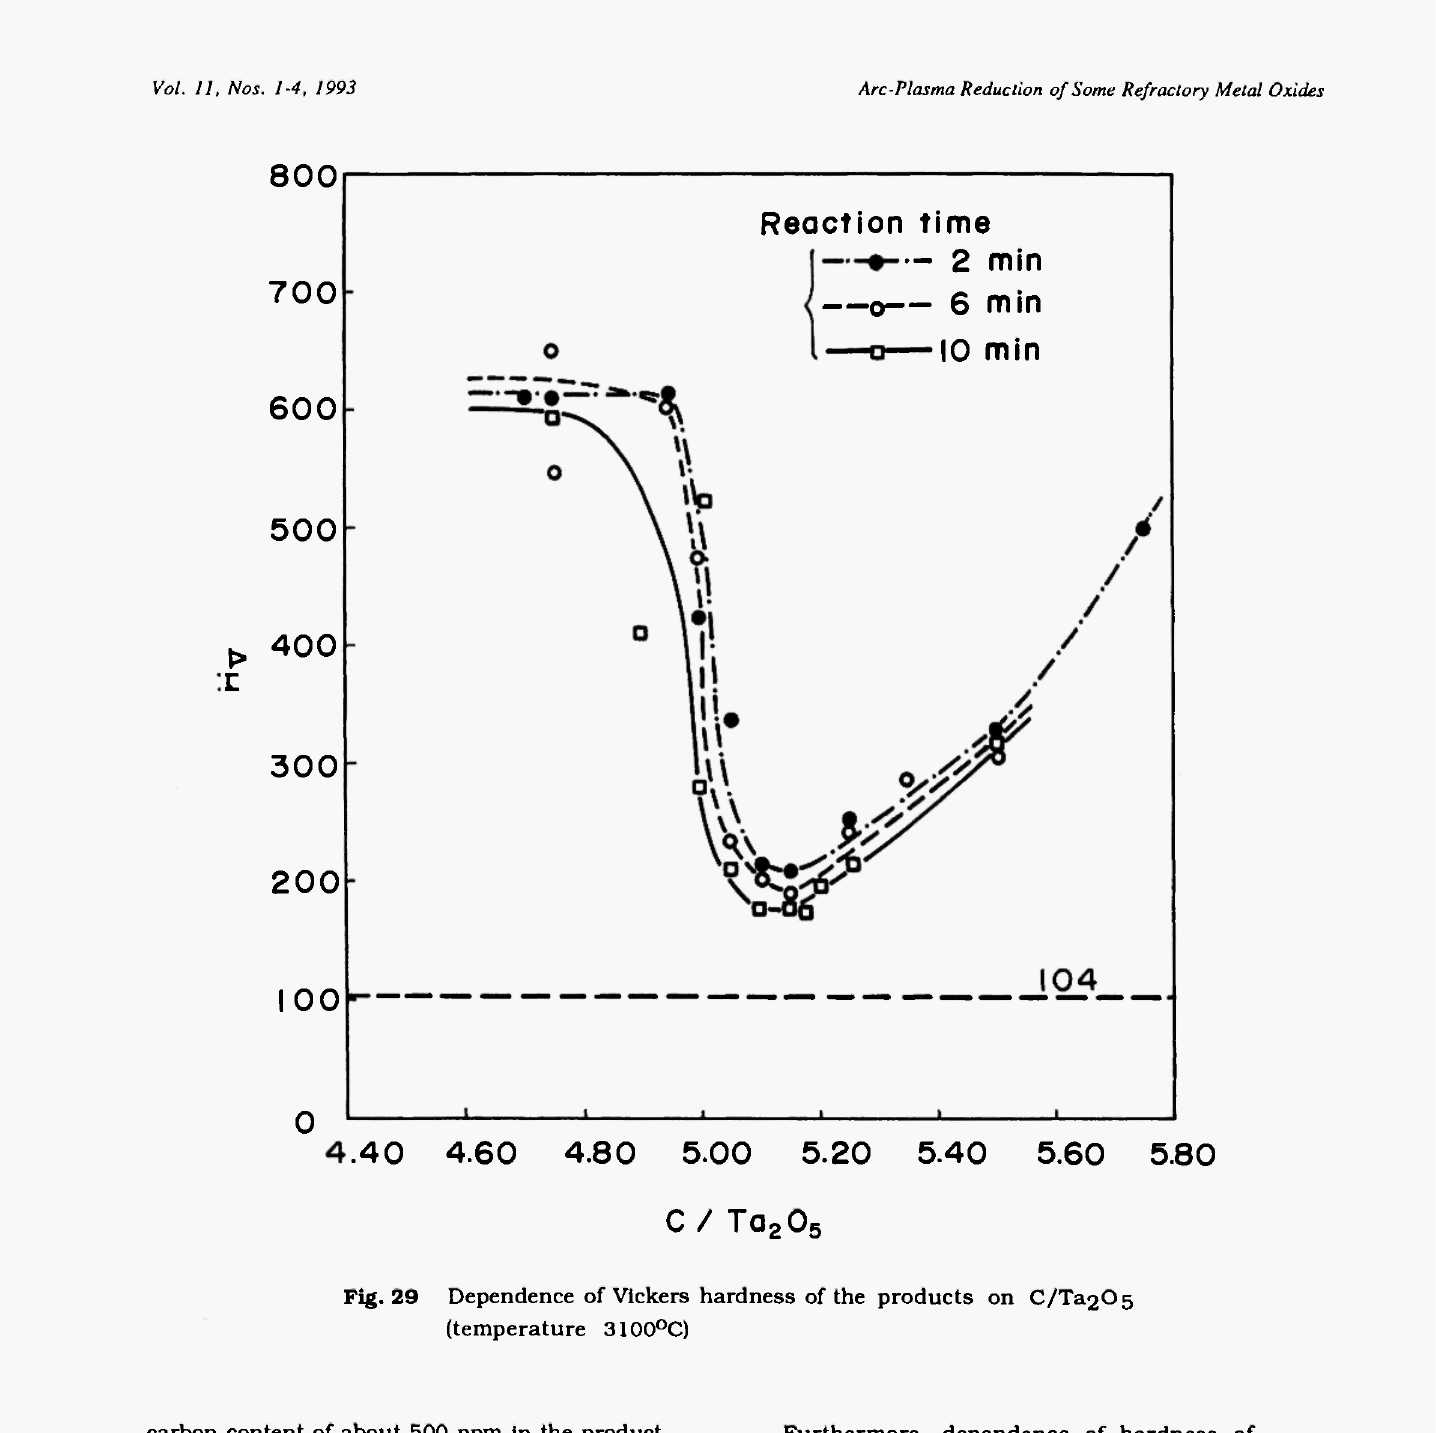
Dependence of Vickers hardness of the products on C/Ta2C>5 (temperature